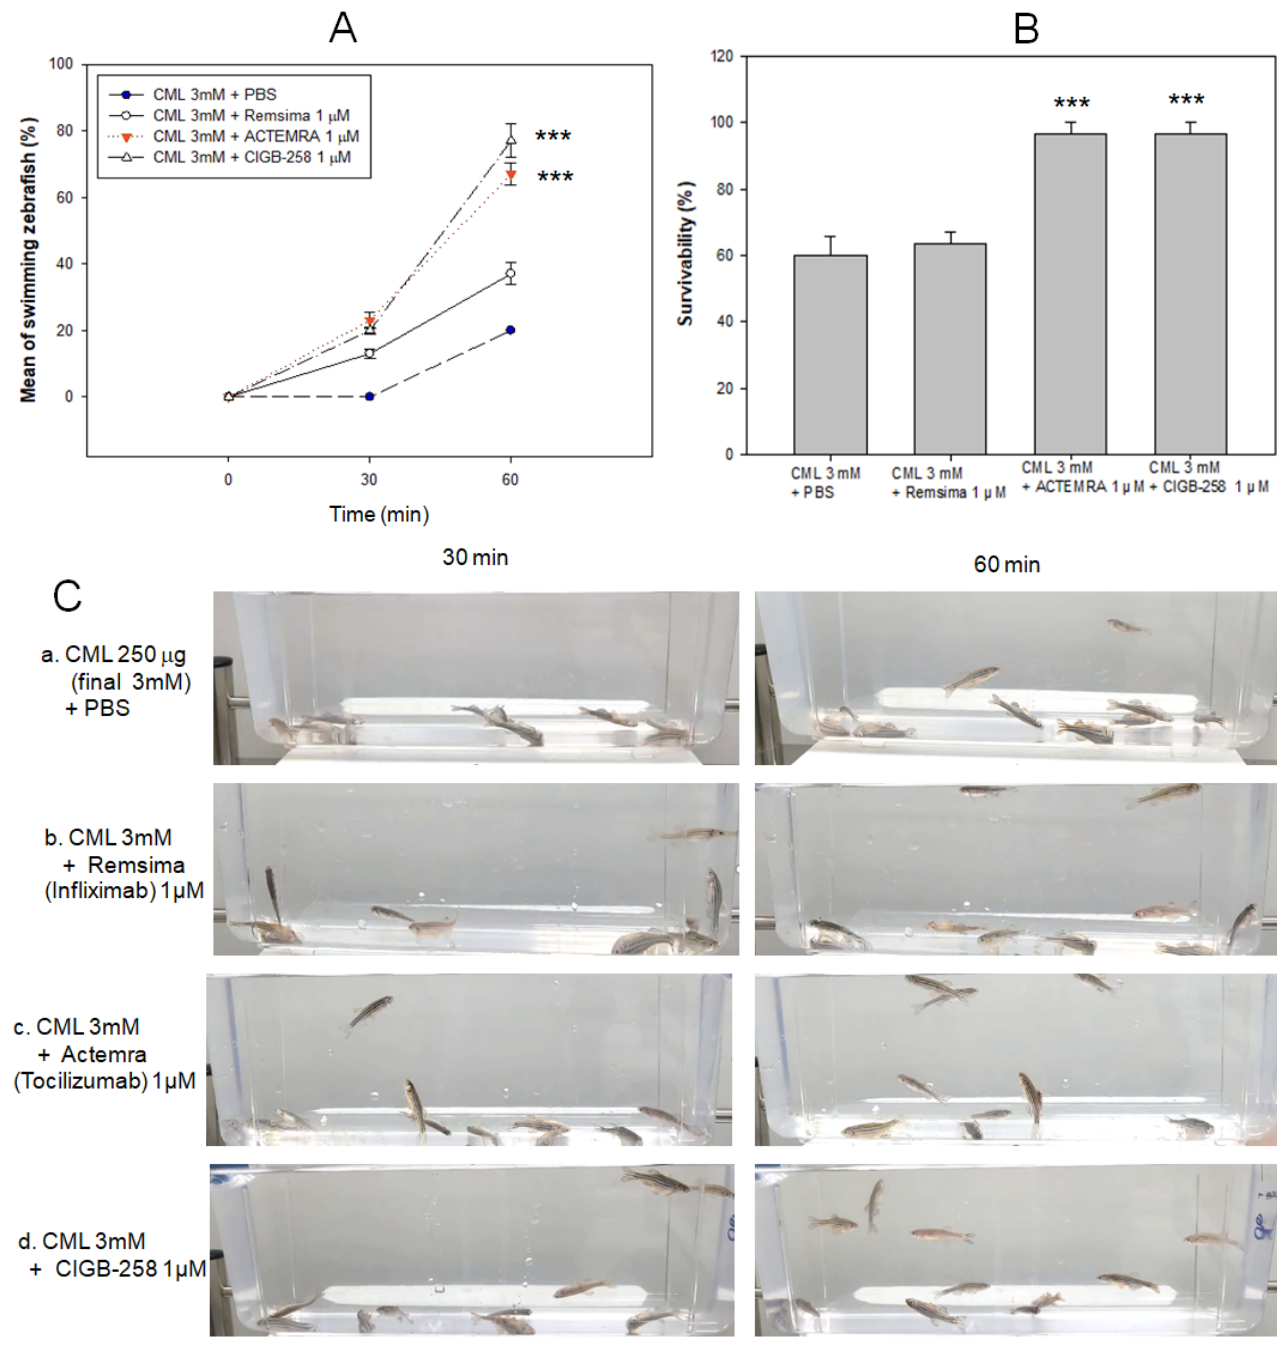
Figure 7. Comparison of the swimming ability and survivability after intraperitoneal injection of carboxymethyllysine (CML) with Infliximab (Remsima), Tocilizumab (Actemra), or CIGB-258 (Jusvinza). ( A ) Percentage of swimming zebrafish after injection of CML with Infliximab (Remsima), Tocilizumab (Actemra), or CIGB-258 at 30 min and 60 min post-injection. *** p < 0.001 versus CML + PBS. ( B ) Survivability of zebrafish at 60 min post-injection of CML with Infliximab (Remsima), Tocilizumab (Actemra), or CIGB-258. *** p < 0.001 versus CML + PBS. ( C ) Still image of swimming pattern of zebrafish after 30 min and 60 min post-injection of CML with Infliximab (Remsima), Tocilizumab (Actemra), or CIGB-258 at 30 min and 60 min